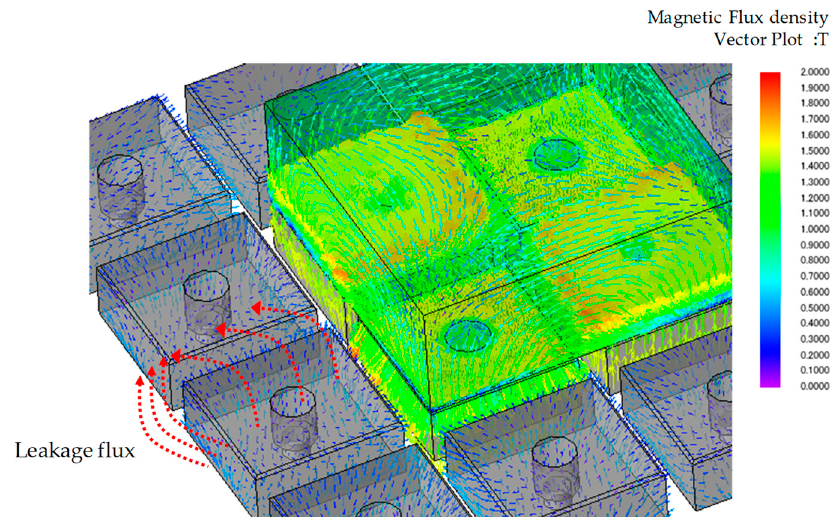
Figure 9. Leakage flux between upper and lower cores surrounding the H-EMMs.